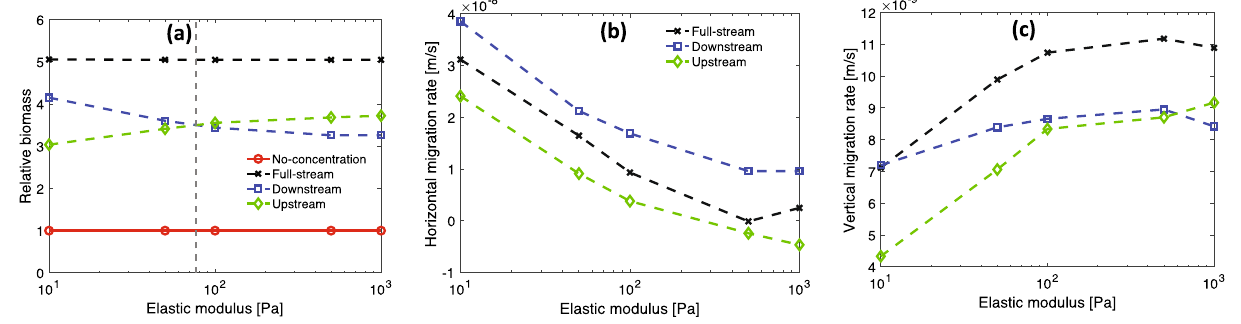
Figure 7. Comparison of growth and migration rate of viscoelastic biofilms in different nutrient source configurations and at a shear flow value u max = 5 × 10 − 6 m/s over a range of elastic moduli. ( a ) Ratio of the biomass of the biofilms at 2.5 h to their initial biomass. Below E ≈ 80 Pa biofilms grow more in a downstream configuration relative to an upstream configuration. Above E ≈ 80 Pa biofilms grow more in an upstream configuration relative to a downstream configuration. In the symmetric full-stream and no-concentration configurations, biofilm growth is independent of the elastic modulus. ( b ) Horizontal migration rate. The nearly constant offset between the downstream and upstream configurations provides a measure of the migration rate toward the nutrient source. The full-stream configuration provides a measure of the migration rate in response to shear flow. In the limit of large elastic modulus, the strain rate becomes negligible and the migration rate is due primarily to growth toward the nutrient source. ( c ) Vertical migration rate. Soft biofilms in the downstream and the full-stream configurations have similar migration rates. Stiff biofilms in downstream and upstream configurations have similar migration